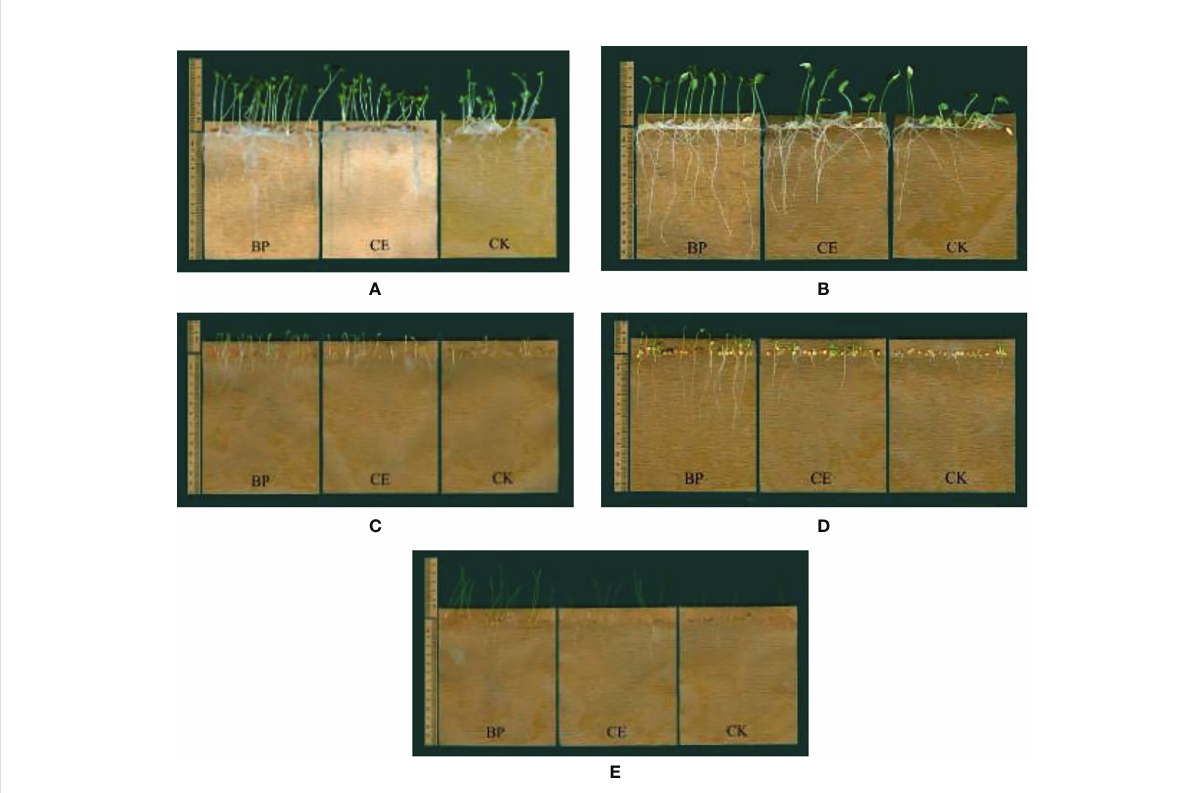
FIGURE 6 Effect of maize root exudates on the growth of recipient seedlings. (A – E) shows the effects of CE and CK root exudates on the growth of radish, cucumber, lettuce, pepper and ryegrass respectively. BP indicates the blank control without any treatment, CE indicates the effect of maize root exudates on recipient plant seedling growth after C.etunicum colonization, CK indicates the effect of maize root exudates without AMF colonization on recipient plant seedling